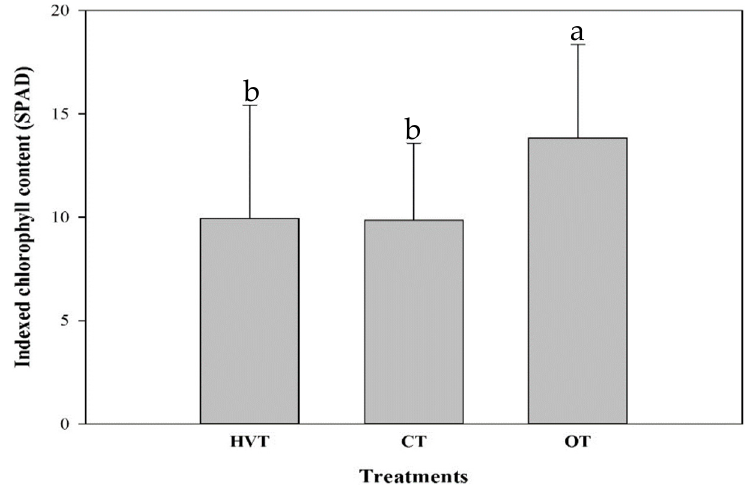
Figure 6. Average indexed chlorophyll content for Pak choi for each treatment. Means followed by the same letter are not significantly different ( p < 0.05, Tukey multiple comparison tests). HVT is the high-temperature oscillation pattern, CT is the fixed temperature regime, and OT is the inside temperature of a net house.